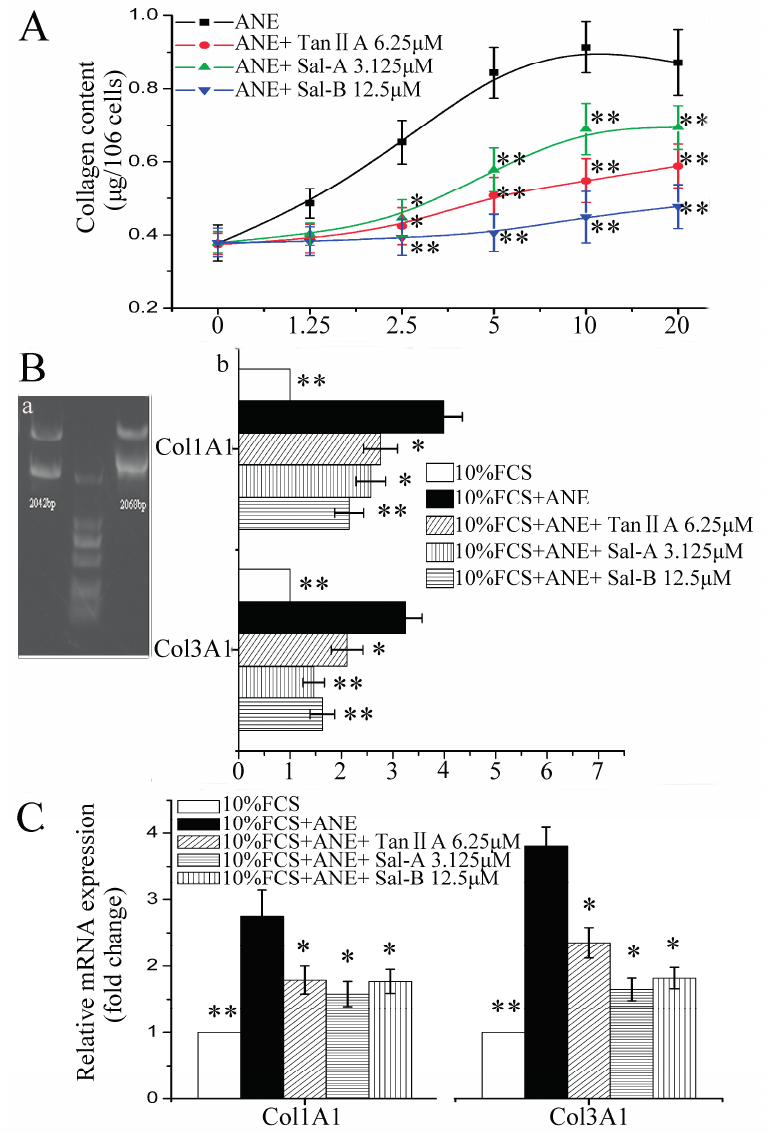
Figure 2. Tan-IIA, Sal-A and Sal-B inhibited the ANE-induced collagen accumulation and transcription of procollagen genes COL1A1 and COL3A1 . ( A ) Tan-IIA, Sal-A and Sal-B inhibited the ANE-induced collagen accumulation; n = 5, * p < 0.05 and ** p < 0.01 vs. the group only treated with ANE. ( B ) Tan-IIA, Sal-A and Sal-B decreased the promoter activity of human procollagen genes COL1A1 and COL3A1. (a) Double-enzyme digestion of pCol1A1-p-Luc and pCol3A1-p-Luc plasmids; (b) luciferase reporter plasmid assay; the results are shown as the fold change of the 10% FCS control. n = 5, * p < 0.05 and ** p < 0.01 vs. the control containing 10% FCS and ANE (12.5 μ g/mL). ( C ) qRT-PCR assay. MOMFs were treated as in the gelatin zymography assay. The 2 −ΔΔ Ct values were calculated, and the results are expressed as the fold change of the 10% FCS control. n = 5, * p < 0.05 and ** p < 0.01 vs. the control containing 10% FCS and ANE (12.5 μ